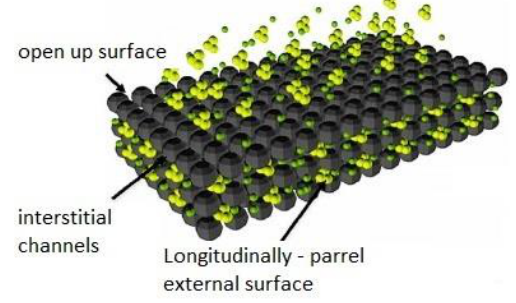
Fig. 2. Structure and adsorption site of graphene sheets